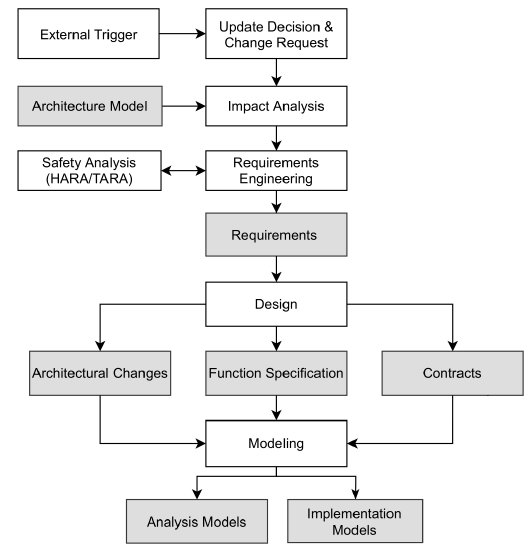
Figure 5. Design Phase of the Update Development